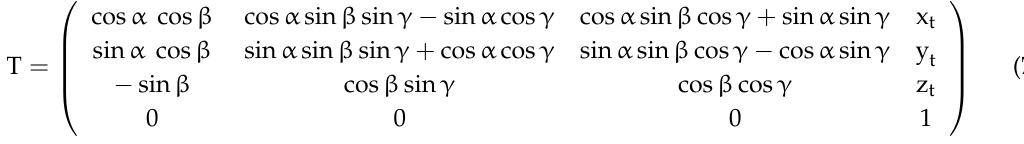
Figure 10. Measurement of the calibration factor in x axis.